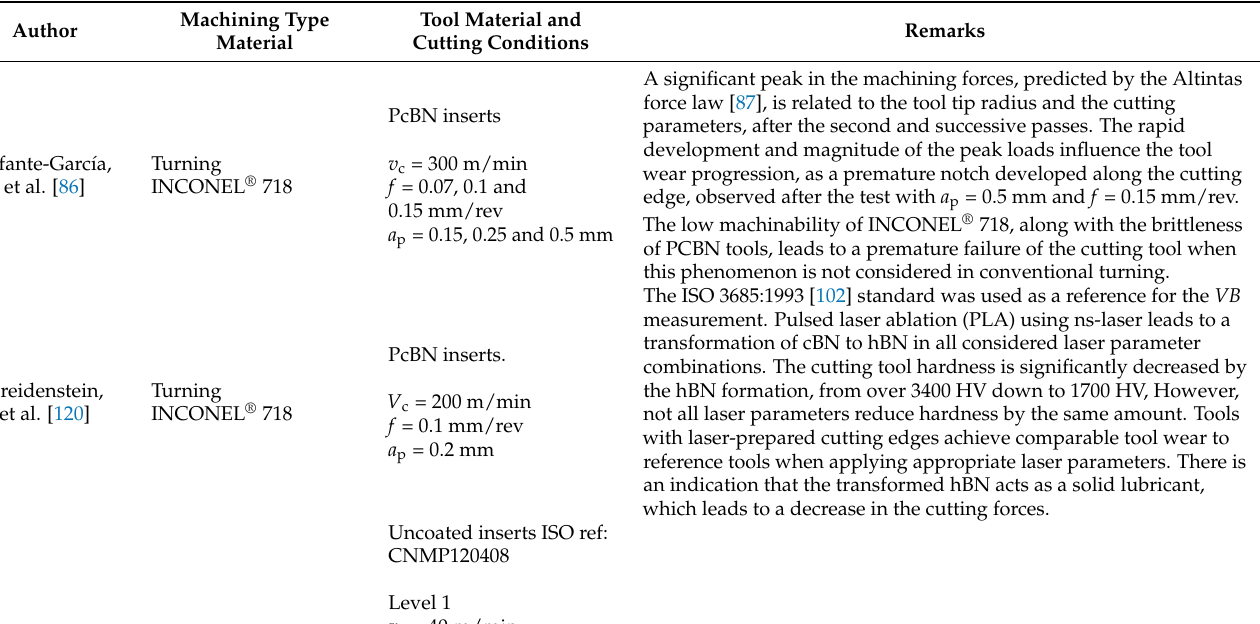
Table 11. Machinability performance during non-coated tools assisted machining of INCONEL ®